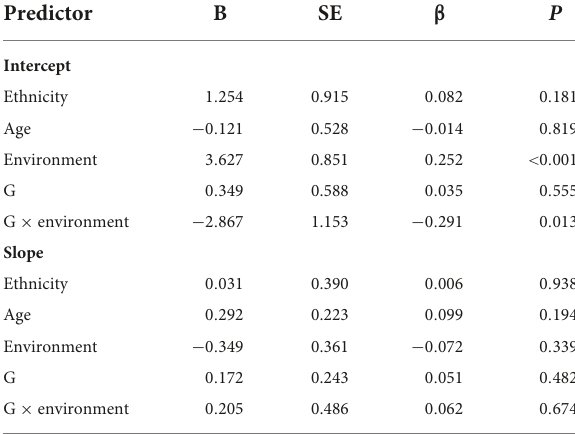
TABLE 4 Main and gene–environment interaction effects of rs2267735 on the course of posttraumatic stress disorder symptoms between 2.5 and 5.5 years after the earthquake (in